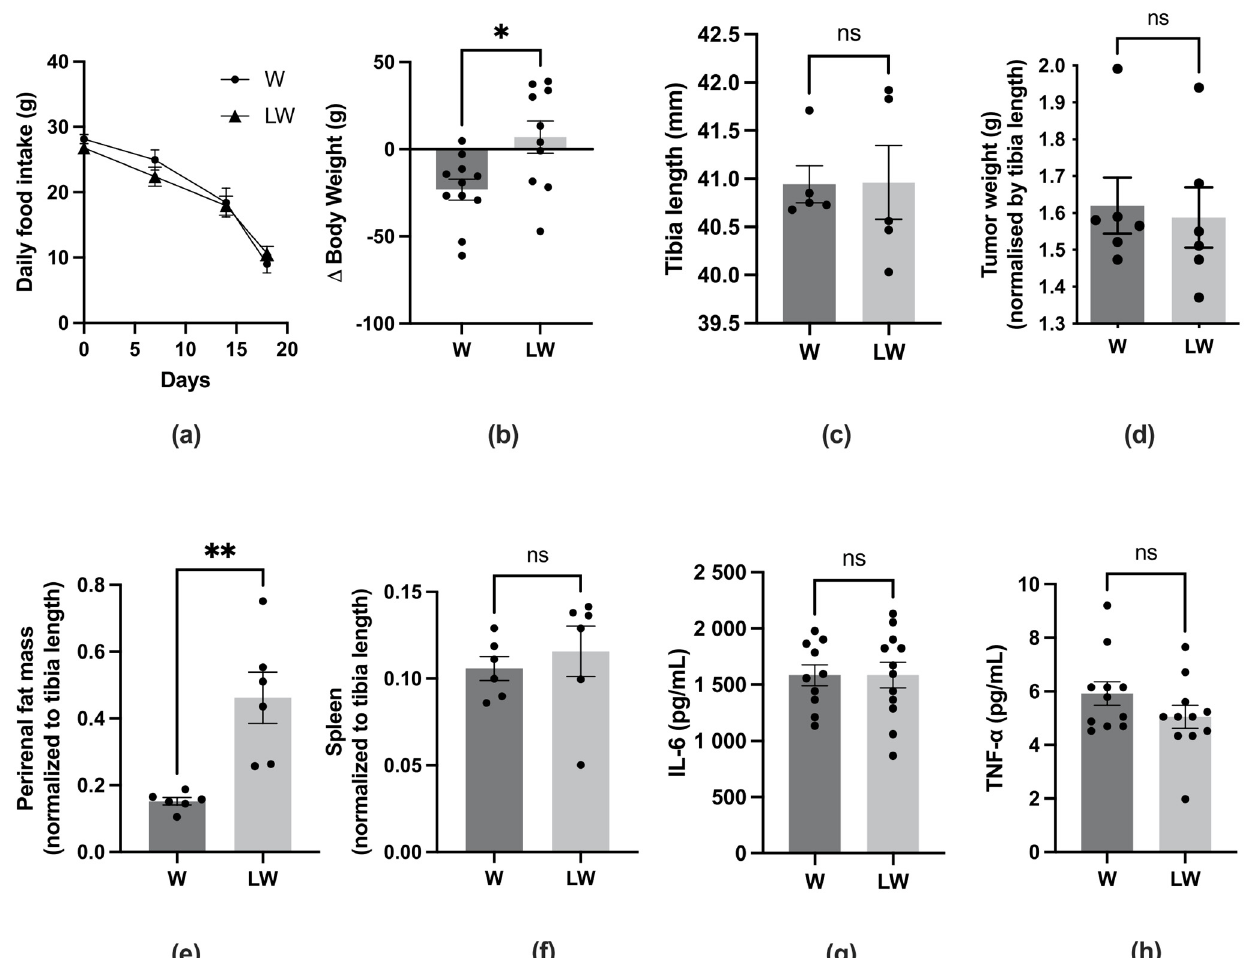
Figure 4. Morphological parameters. ( a ) Daily food intake (g) during the experimentation protocol; ( b ). Delta body weight (g) ((final body weight-tumour weight)-initial body weight); ( c ) Tibia length (mm); ( d ) Tumour weight (normalised by the respective tibia length); ( e ) White adipose tissue mass (perirenal) (normalised by the respective tibia length); ( f ) Spleen mass (normalised by the respective tibia length); ( g ) Serum IL6 concentration (pg/mL); ( h ) Serum TNF- α concentration (pg/mL). For details, see the Methods section. N = minimum of 6 animals per group. Graphics represent mean ± SEM. * p < 0.05, ** p < 0.01, and ns = not significant by t -test.